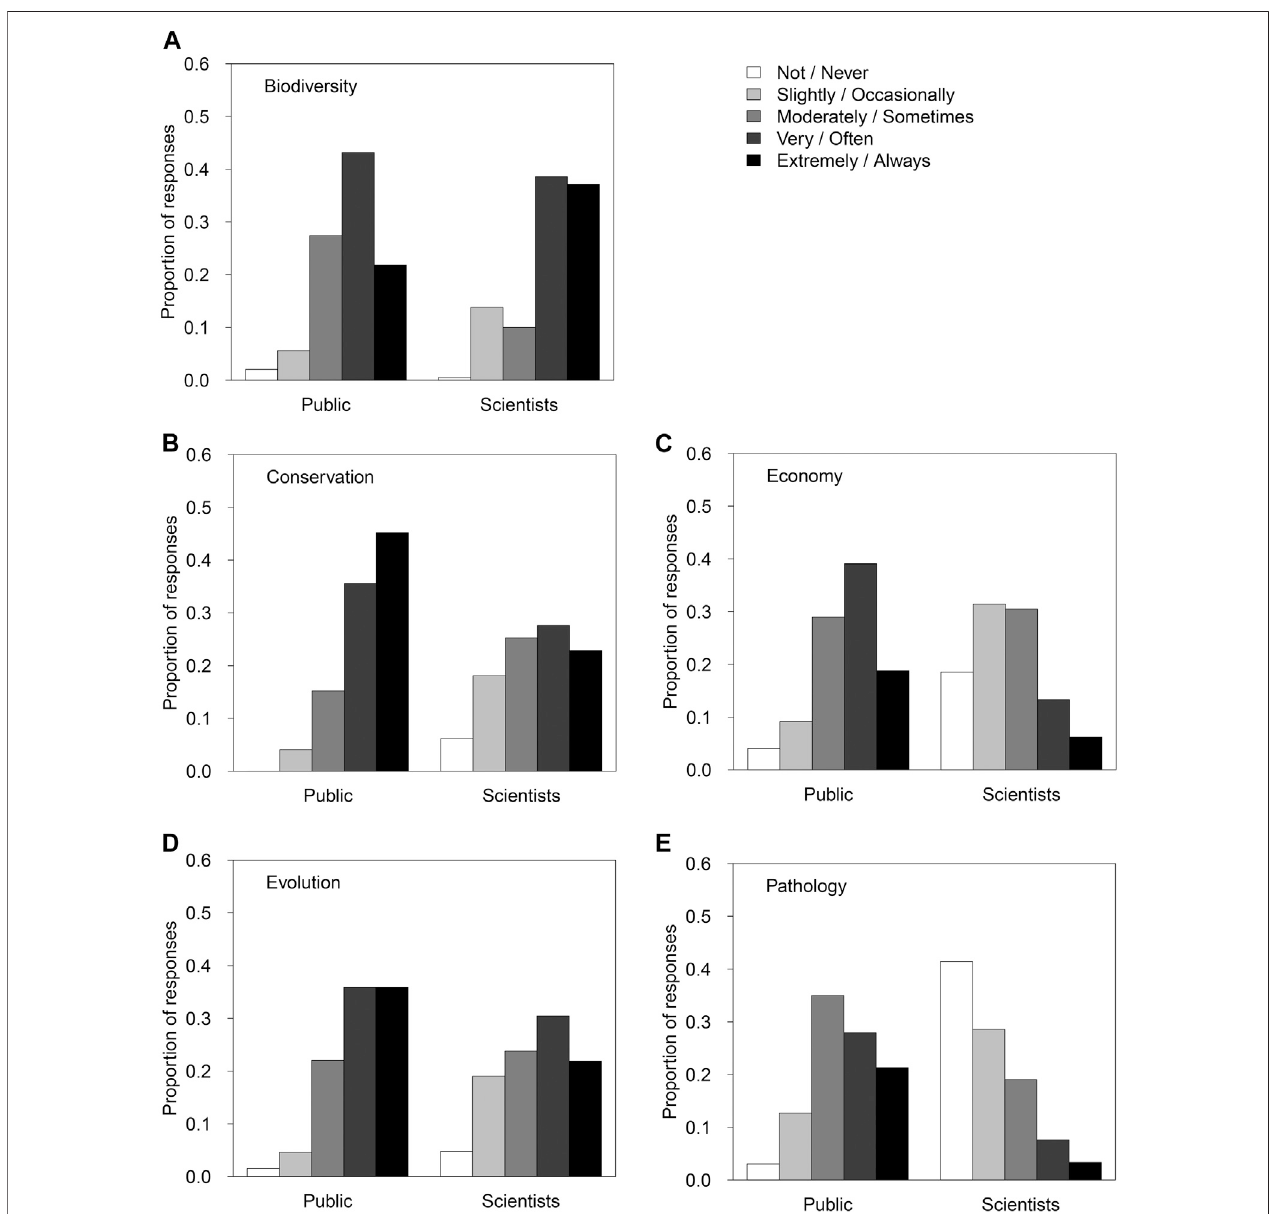
FIGURE 1 | Comparison between public interest and how often scientists use the typical fi ve overarching topics during their science communication/outreach activities (Q2.16 and Q1.11, respectively). (A) biodiversity; (B) conservation; (C) economical applications; (D) evolution; (E) pathology.